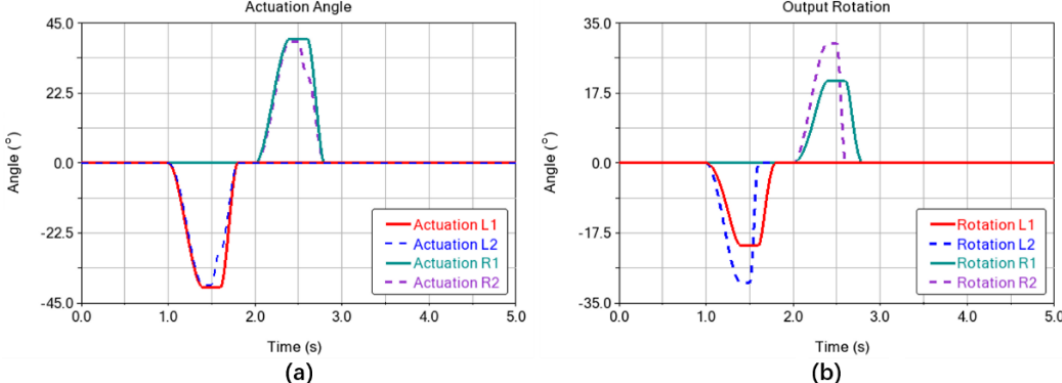
Figure 13. (a) The actuation in one sprawling cycle. (b) The output rotation of a pair of mechanisms in one sprawling cycle.